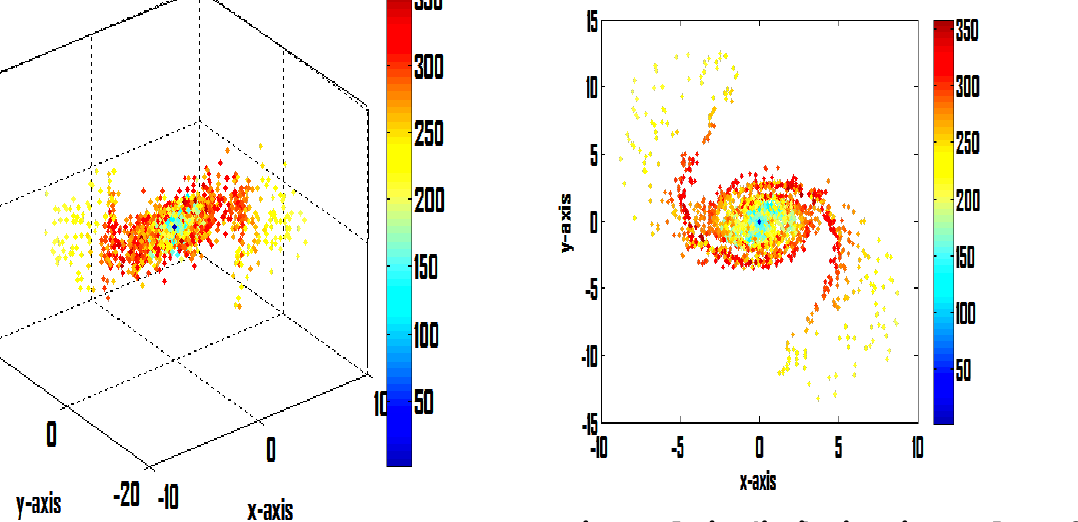
Fig.7: Velocity distributions of the spiral hot disk in space after 322.9 million years.